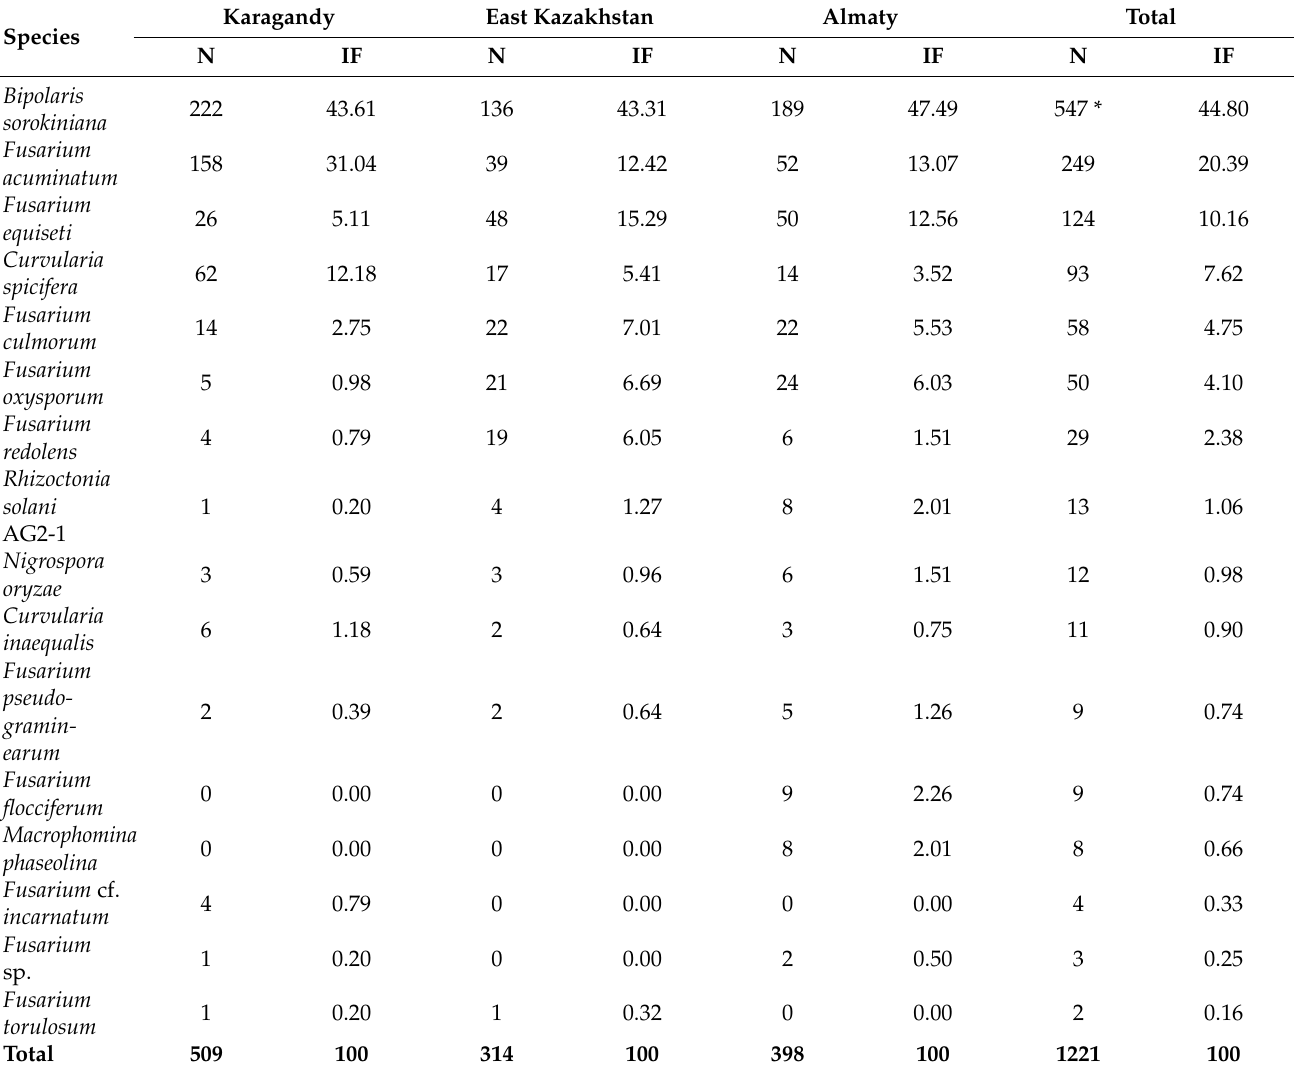
Table 1. The number of isolates associated with wheat crown/root rot and isolation frequency obtained from three different wheat-growing regions in